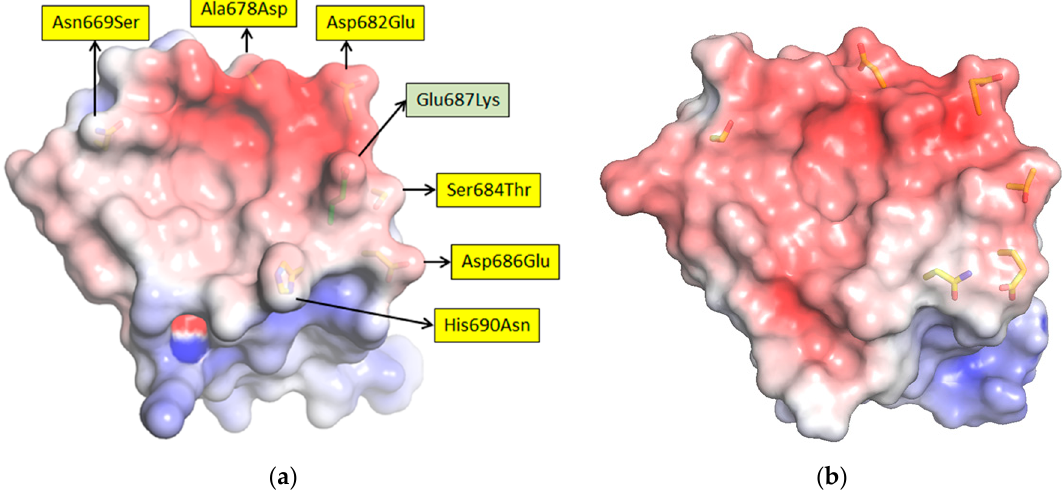
Figure 9. ( a ) Pymol rendering of the electrostatic surface potential of the Musoke NP C-terminal domain with scale ranging from − 5 (red) to + 5 (blue) K b T / e c . Side-chains of predicted sdAb contacts mutated in the MLAV NP are shown as sticks, with arrows to yellow labels indicating the changes. The arrow to green label highlights a mutation occurring in two laboratory mouse-adapted MARV Ci67 isolates. ( b ) Electrostatic surface potential of an I-TASSER generated model of MLAV NP C-terminal domain based upon a template of PDB ID 6APP_B with the sdAb contact mutations shown as sticks. Six amino-acid mutations may directly impact sdAb binding; four are conservative (Asp682Glu, Ser684Thr, Asp686Glu and His690Asn) and two are not (Asn669Ser and Ala678Asp). The altered